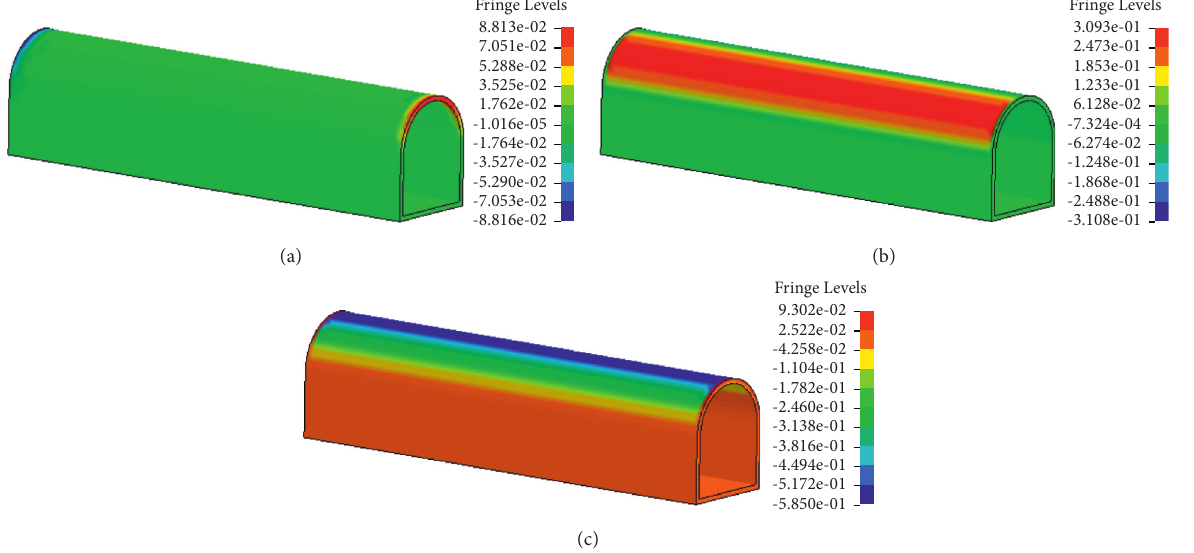
Figure 6: The displacement nephograms of the existing tunnel structure in condition